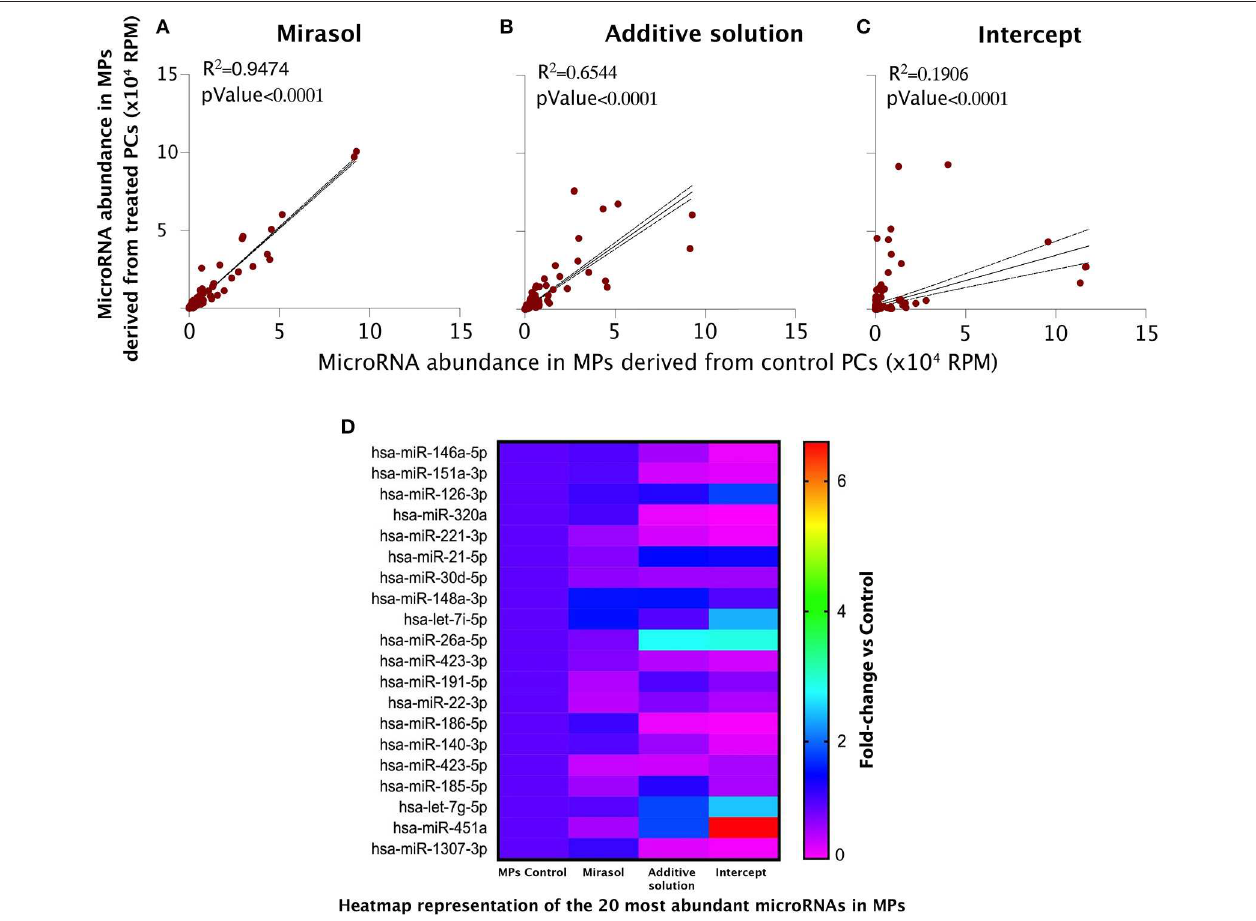
FIGURE 3 | MicroRNA profile of the MPs derived from human platelets subjected to PRT treatment. MPs were isolated from PCs that were either left untreated in donor plasma (Control group) or treated with PRT agents Mirasol or Intercept, or with the Additive solution, used as the vehicle control for Intercept. (A–C) Pearson’s correlation of the microRNA abundance in platelet MPs isolated from Mirasol-treated platelets (A) , Additive solution-treated platelets (B) , or Intercept-treated platelets (C) vs. control MPs. MPs, microparticles; RPM, reads per million. (D) Heatmap representation of the 20 most abundant microRNAs in MPs, where fold changes vs. control PCs are indicated in graded color intensity. MPs, microparticles; PCs, platelet concentrates; PRT, pathogen reduction technologies; RPM, reads per